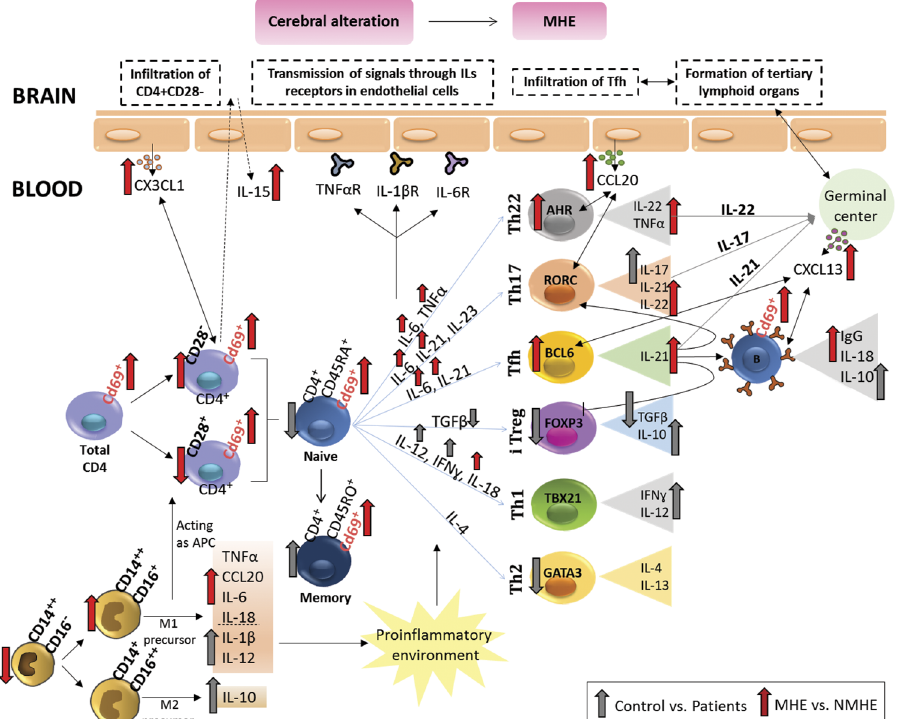
Figure 6. Scheme summarizing the changes in the immunophenotype associated with MHE and hypotheses on how this may affect the brain and lead to MHE. The main alterations associated with MHE are: (1) Increased activation of all subtypes of CD4 + T-lymphocytes, as indicated by the increased expression of CD69. (2) An increased amount of CD4 + CD28 − T lymphocytes, associated with increased levels of CX3CL1 (fractalkine) and of IL-15, which may promote their infiltration into the brain. (3) Increased differentiation of CD4 + T lymphocytes to Th follicular and Th22, which may promote the formation of tertiary lymphoid organs in brain. (4) Increased activation of B lymphocytes and serum IgG. These four main alterations may contribute separately or jointly to alter cerebral function and to the appearance of the neurological alterations associated to MHE in cirrhotic patients. Some possible mechanisms by which changes in peripheral inflammation in patients with MHE may contribute to the appearance of the neurological alterations are: ( a ) infiltration into the brain of CD4 + CD28 − T lymphocytes, leading to neuroinflammation and neurological impairment; ( b ) activation by peripheral interleukins (TNF α , IL-1b, IL-6) of their receptors in endothelial cells, triggering the release of inflammatory factors into the brain, neuroinflammation and neurological alterations; ( c ) infiltration of Tfh cells and formation of tertiary lymphoid organs with B lymphocytes germinal centers, leading to neurological